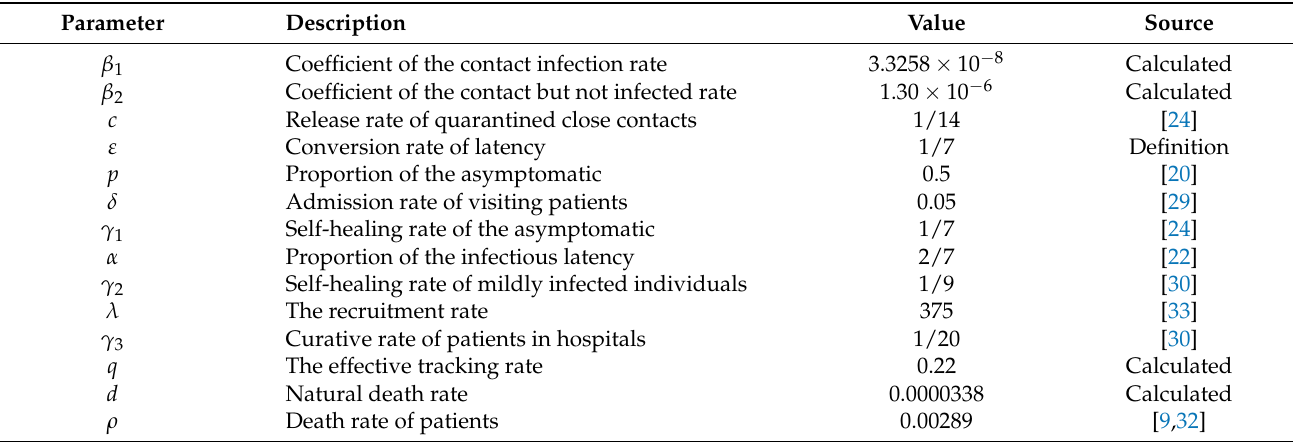
Table 2. Parameters and